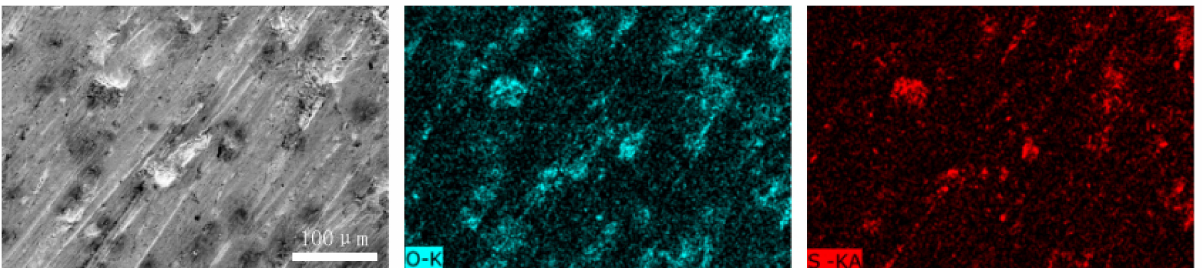
Figure 13. SEM morphology of worn surfaces of NM400 with varying pH values of simulated mine water at the percentage of coal gangue of 50%: 3.5 ( a ), 7 ( b ), 11.5 ( c ).